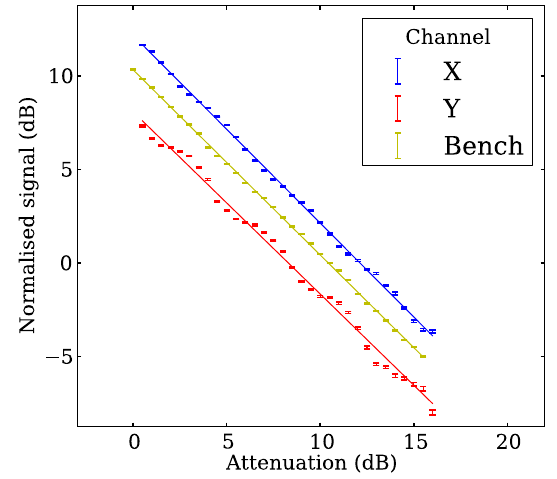
FIG. 7. Peak signals from the horizontal and vertical position cavity channels normalized by the reference cavity signal for the different settings of the digitally controlled variable attenuator. The attenuation in the reference channel was kept constant. Data from the bench measurement of the variable attenuator is included with an artificial